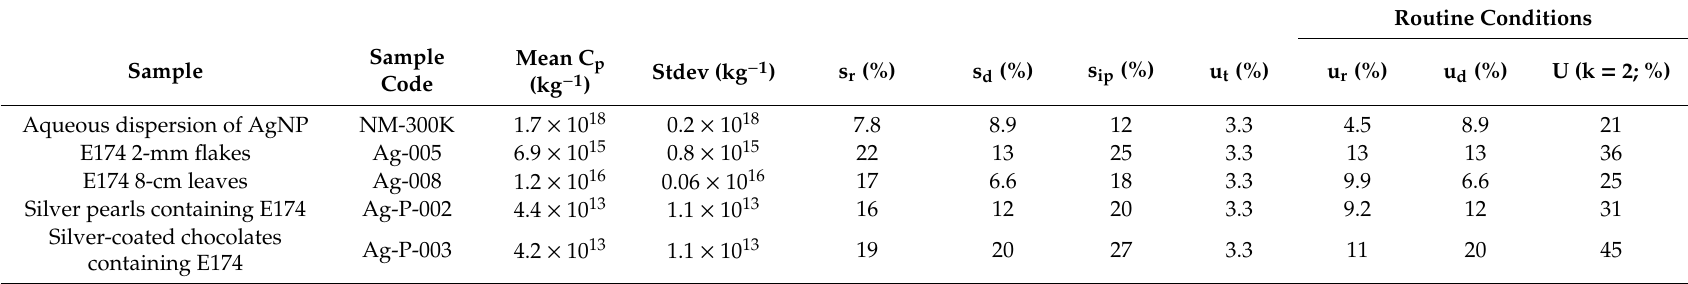
Table 2. Mean particle number concentrations (C p ) and their associated standard deviation, repeatability (s r ), between-day variation (s d ), and intermediate precision (s ip ). Contributions of the trueness uncertainty (u t ), within-day (u r ), and between-day (u d ) uncertainty to the expanded uncertainty (U) on the measurement of the particle number concentration by spICP-MS under routine measurement conditions (3 replicates × 1 day).